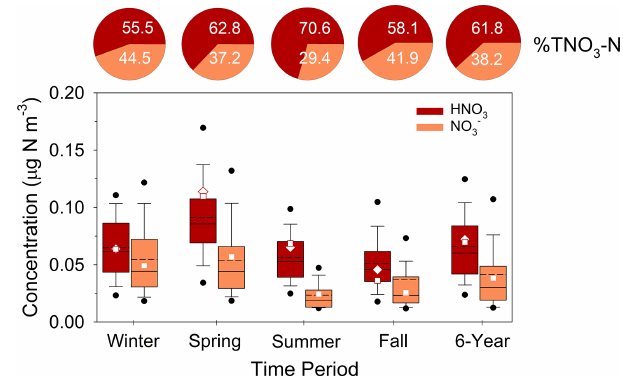
Figure 6. Summary of CASTNET HNO 3 and NO − (as N) from 2015–2020 during winter, spring, summer, and fall. Solid and dashed lines inside the box represent the median and mean, respectively. The top and bottom of the box represent 75th and 25th percentiles. Whiskers represent 10th and 90th percentiles, and dots represent 5th and 95th percentiles. “6-year” represents the statistics for the entire 6-year period. Squares and diamonds repre- sent the seasonal and annual mean CASTNET (HNO 3 and NO − and continuous DD-CL HNO 3 for the August 2015–August 2016 modeling period, respectively. Pie charts represent the average per- cent contribution of HNO 3 and NO − expressed as